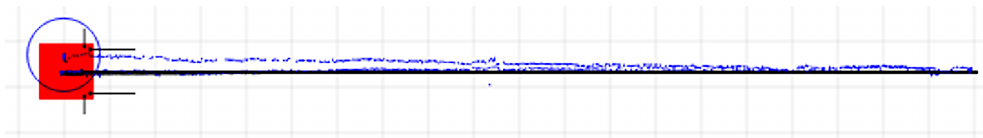
Figure 11. Result after applying the longitudinal translation correction factors obtained by the IPS (translation, forward-translation–rotation, and reverse-translation–rotation correction